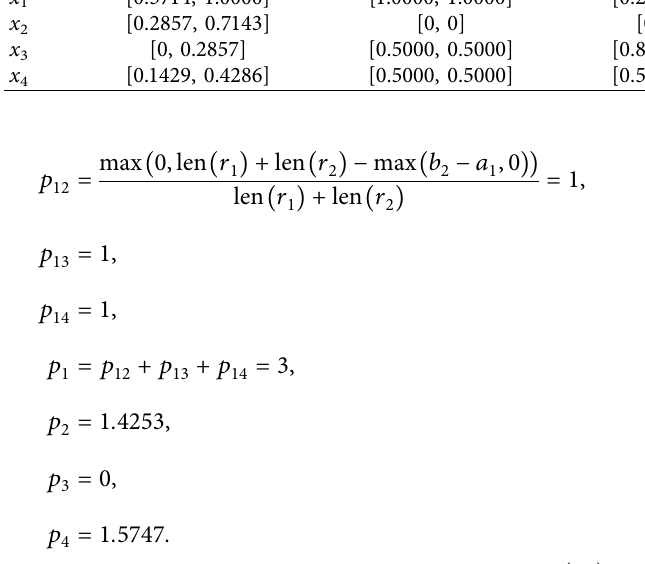
Table 5: Te normalized interview